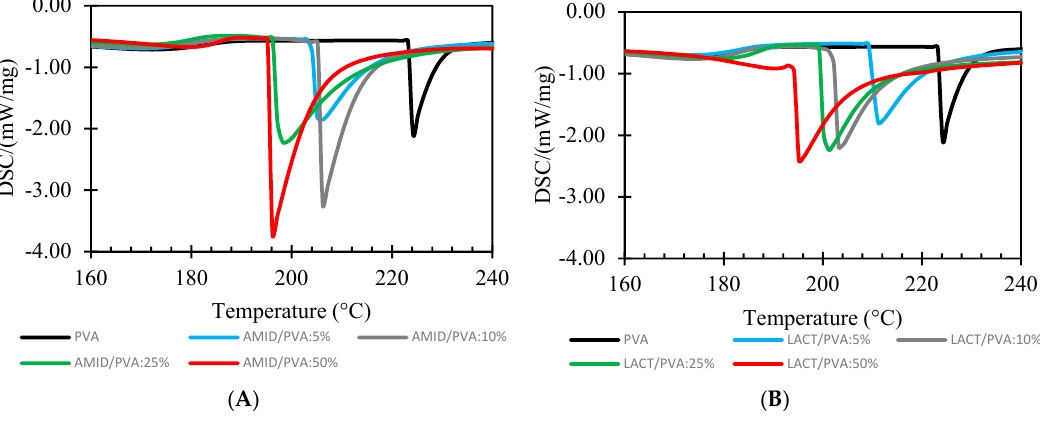
Figure 8. DSC analysis of Amidino POSS ® /PVA ( A ); Lactamide POSS ® /PVA ( B ). PVA (black), 5% (blue), 10% (gray), 25% (green), 50% (red).